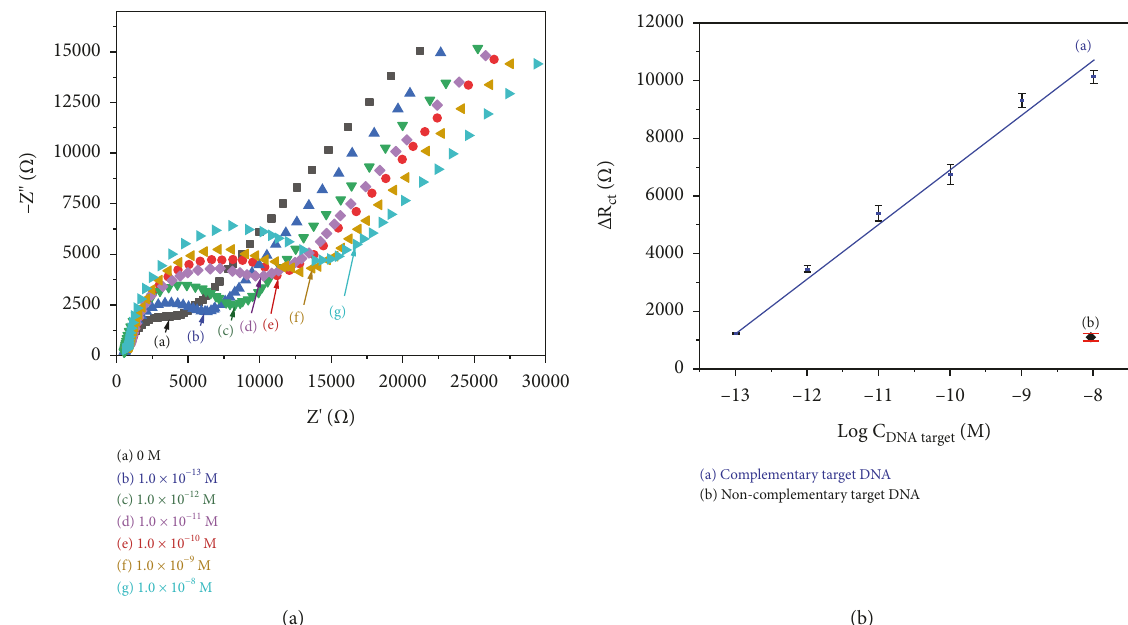
Figure 5: (a) EIS spectra (Nyquist plots) of the DNA sensors after hybridization with different concentrations of complementary target DNA: (a) 0M, (b) 1.0 Experimental conditions: EIS spectra were measured in PBS buffer (pH 7.4) solution consisting K 3 Fe(CN) 6 /K 4 Fe(CN) 6 (0.005 M) and 0.1M KCl, frequency range: 100kHz–100 mHz, E AC centrations of complementary target DNA and (b) 1.0 Surface modification